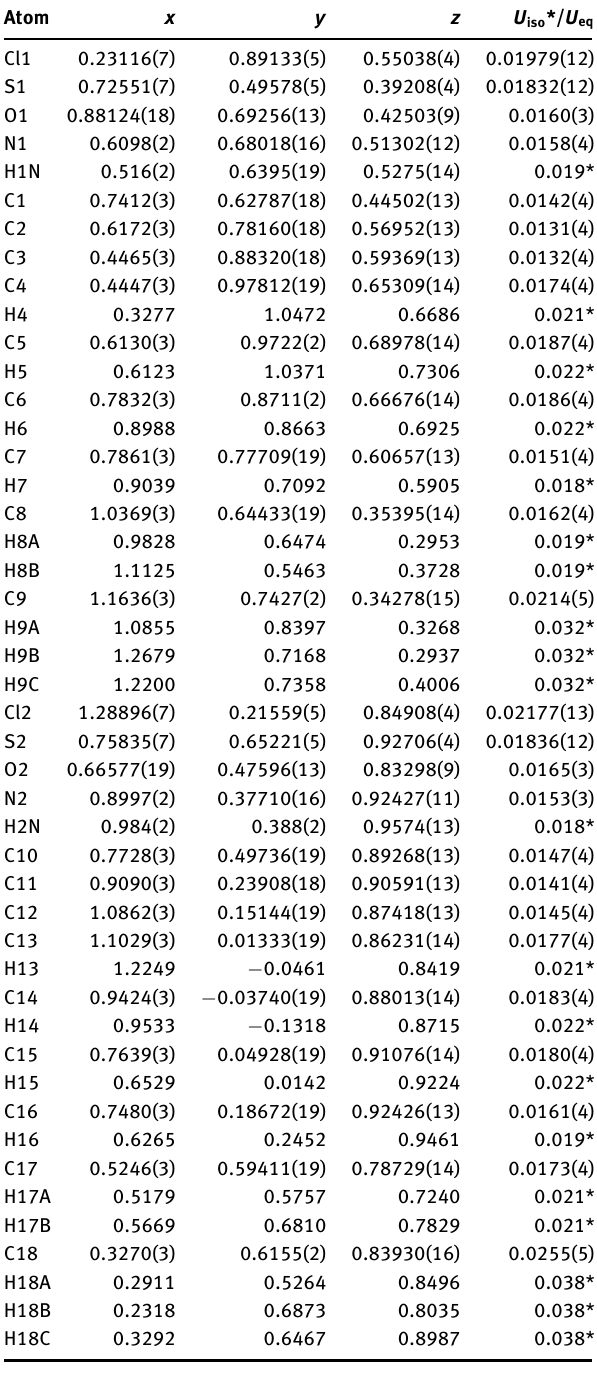
Table 2: Fractional atomic coordinates and isotropic or equivalent isotropic displacement parameters (Å 2